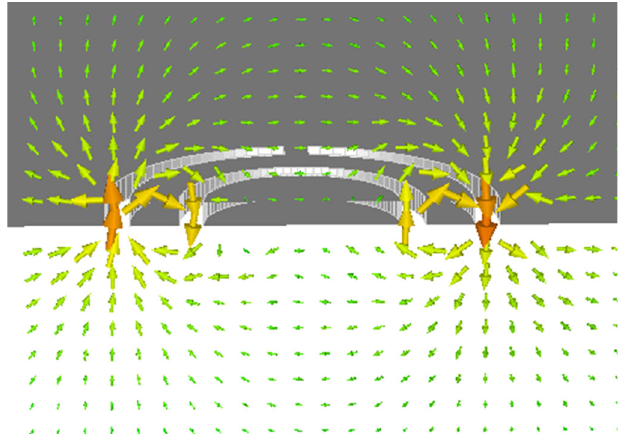
FIG. 5. 2D cut of the CSRR magnetic field at resonance.